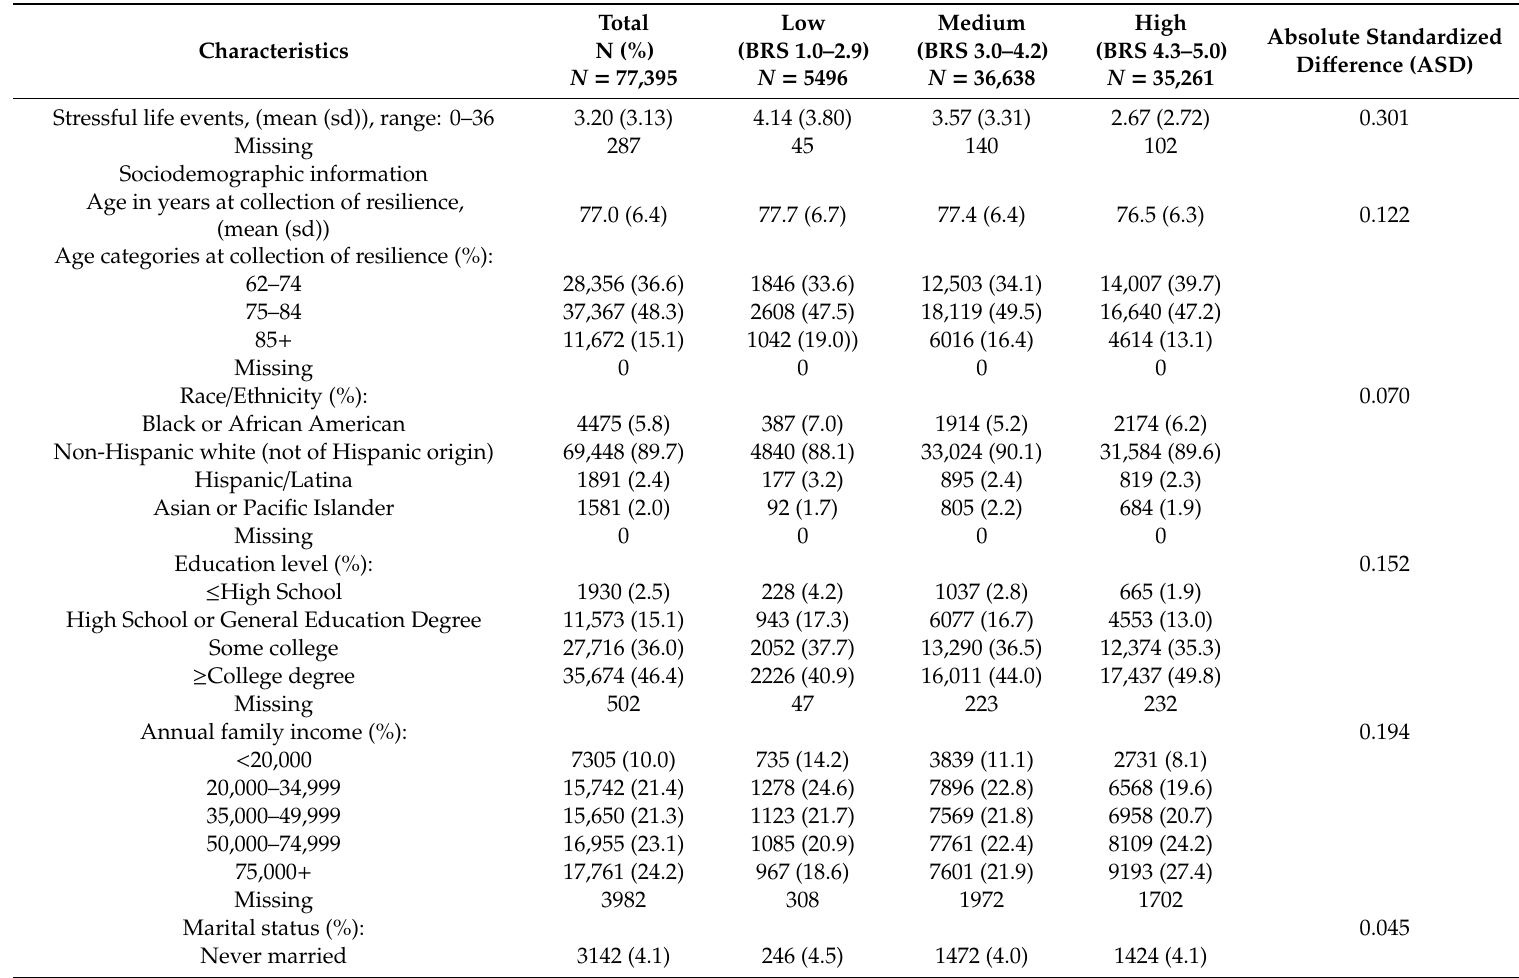
Table 1. Description of perceived stress, sociodemographic information, and other health factors by low, medium, and high levels of self-reported psychological resilience from participants in the Women’s Health Initiative (WHI) Extension Study